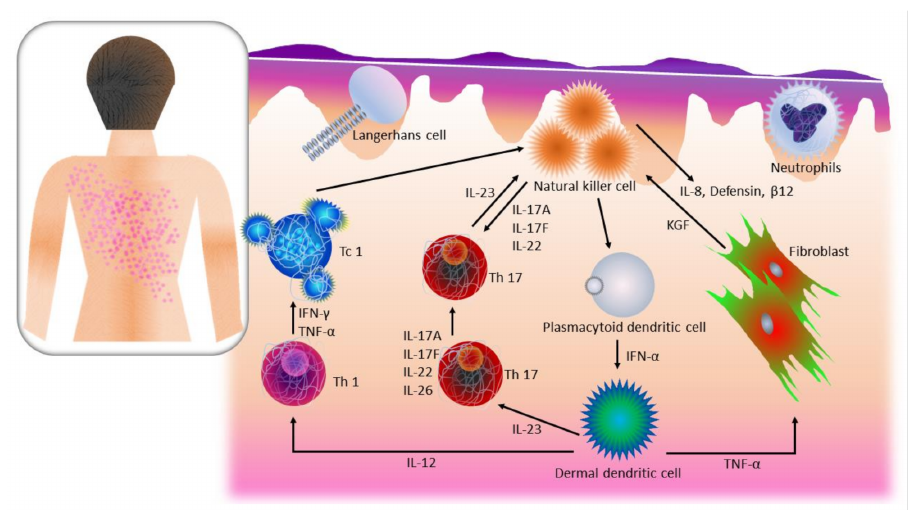
Figure 1. The flowchart of the pathogenic pathway of psoriasis. This figure is self-drawn. 2.1. T Cell Activation, Cytokine Release, and Over-Proliferation of Keratinocytes in